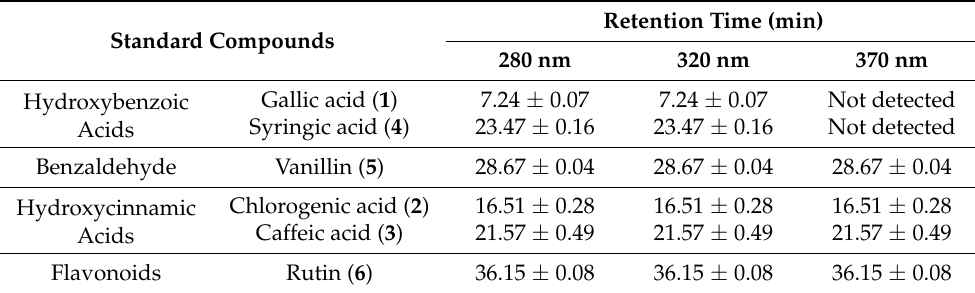
Table 1. Detection wavelengths and retention times of standard phenolic and flavonoid compounds ( n = 3). Standard